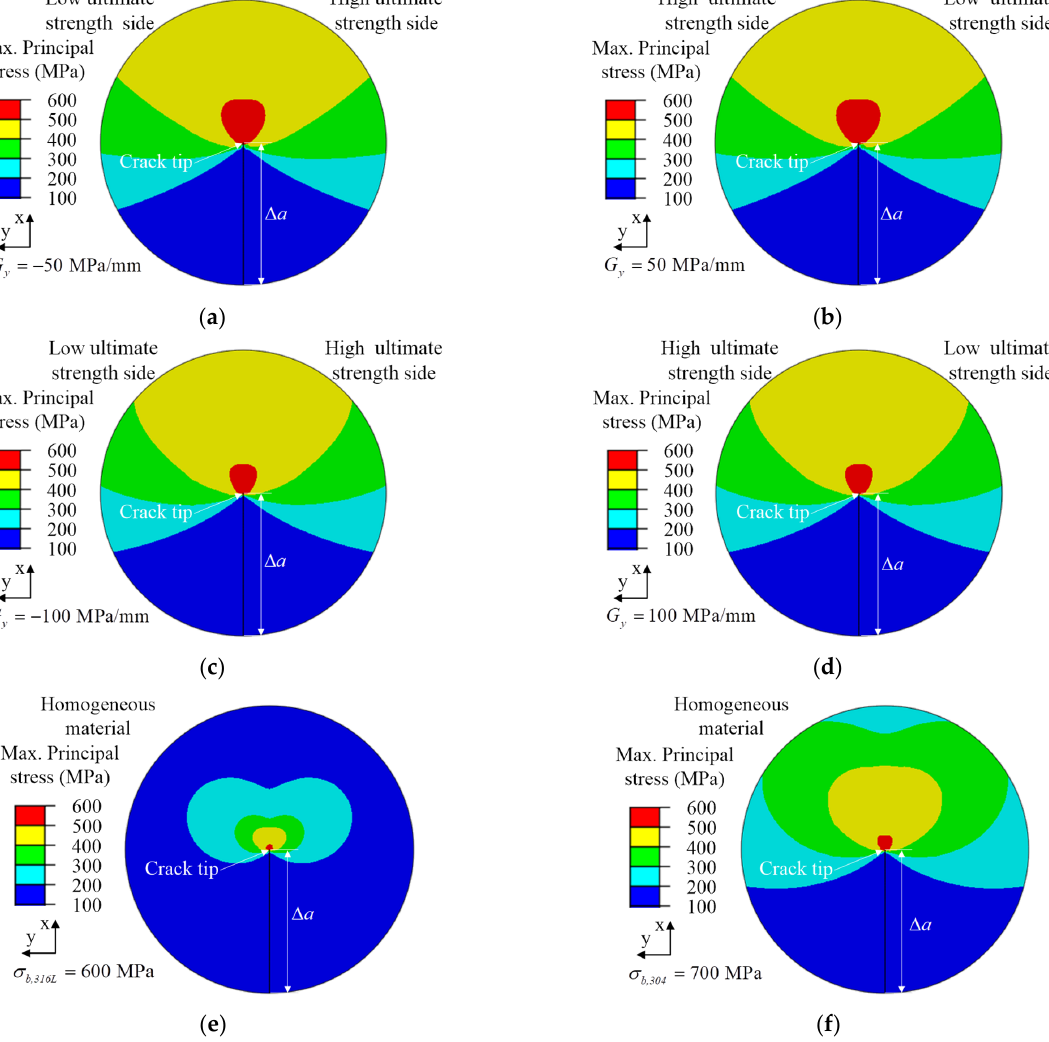
Figure 8. Maximum principal stress field of crack tip with different ultimate strength mismatch co ‐